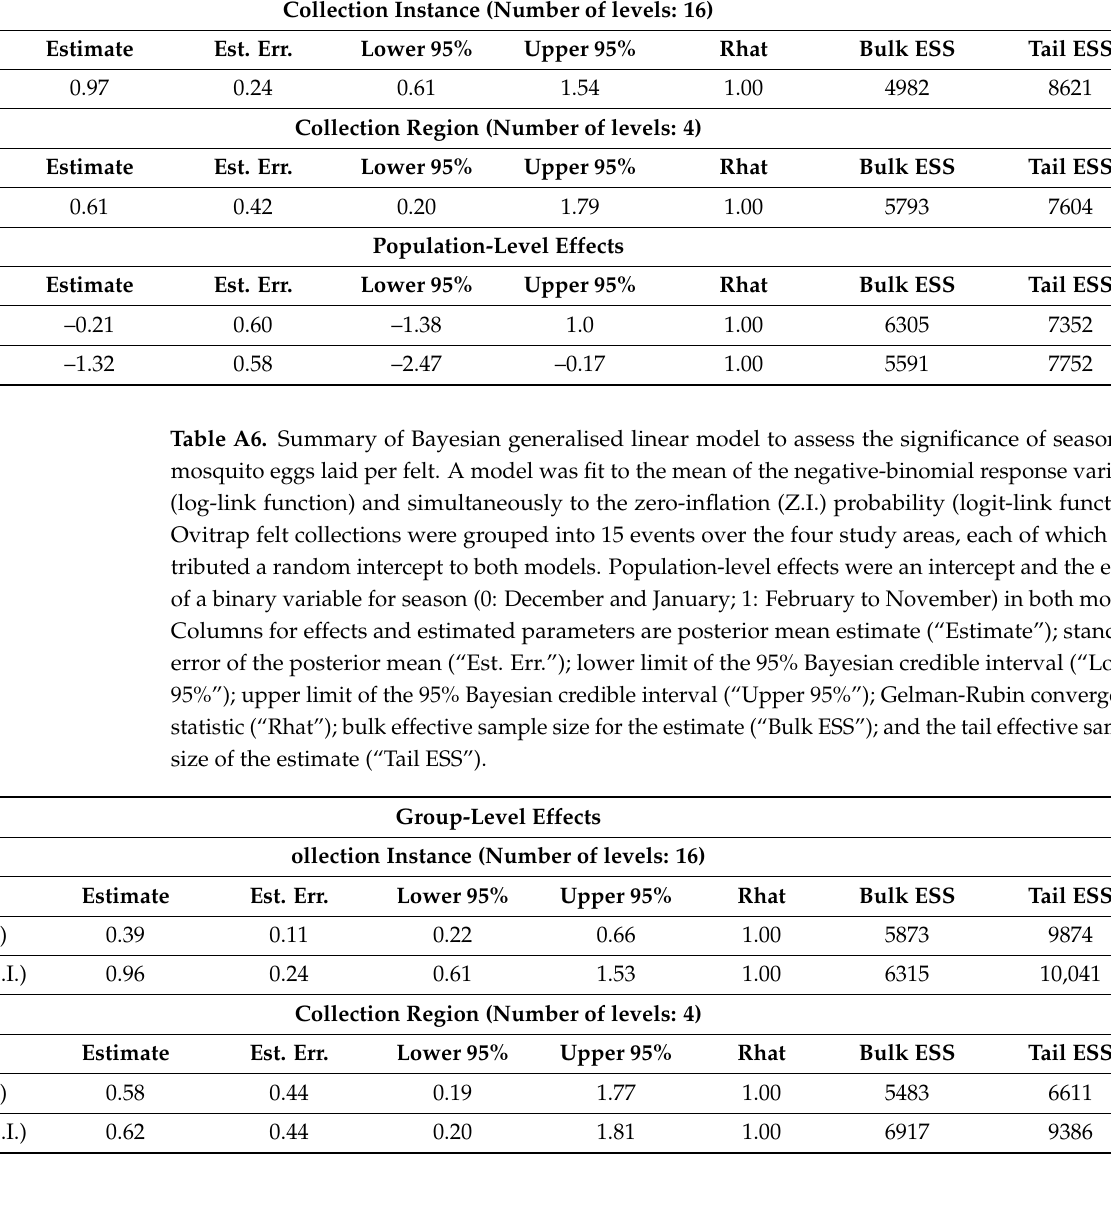
Table A5. Summary of Bayesian generalised linear model to assess the significance of season on mosquito egg presence (Bernoulli response variable, log-link function). Ovitrap felt collections were grouped into 15 events over the four study areas, each of which were modelled using a random intercept. Population-level effects were an intercept and the effect of a binary variable for season (0: December and January; 1: February to November). Columns for effects and estimated parameters are: posterior mean estimate (“Estimate”); standard error of the posterior mean (“Est. Err.”); lower limit of the 95% Bayesian credible interval (“Lower 95%”); upper limit of the 95% Bayesian credible interval (“Upper 95%”); Gelman-Rubin convergence statistic (“Rhat”); bulk effective sample size for the estimate (“Bulk ESS”); and the tail effective sample size of the estimate (“Tail ESS”). Group-Level Effects